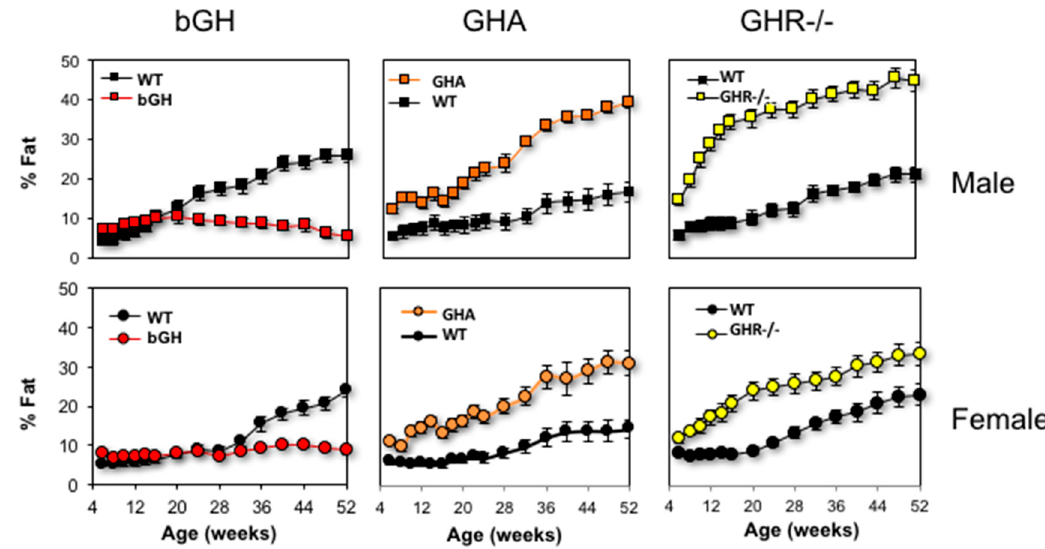
Figure 3. Comparison of body fat percentage in mice with altered GH action. Male and female bGH mice have greater body fat percent than WT mice earlier in life, a trend that starts to reverse at four and six months of age, respectively (left). Fat percentage is greater in male and female GHA mice compared to controls throughout life. Male GHR-/- mice have markedly increased body fat percent compared to controls and appear to rapidly accumulate fat during the first four months of life. Increased percentage of fat is also observed in female GHR-/- mice compared to controls, albeit not as drastic. Adapted with permission from [38]. Copyright 2017 John Wiley & Son.